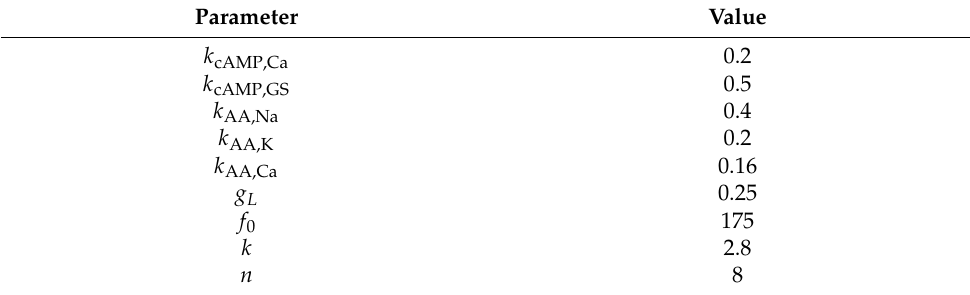
Table 1. Model parameters and their values. Parameter